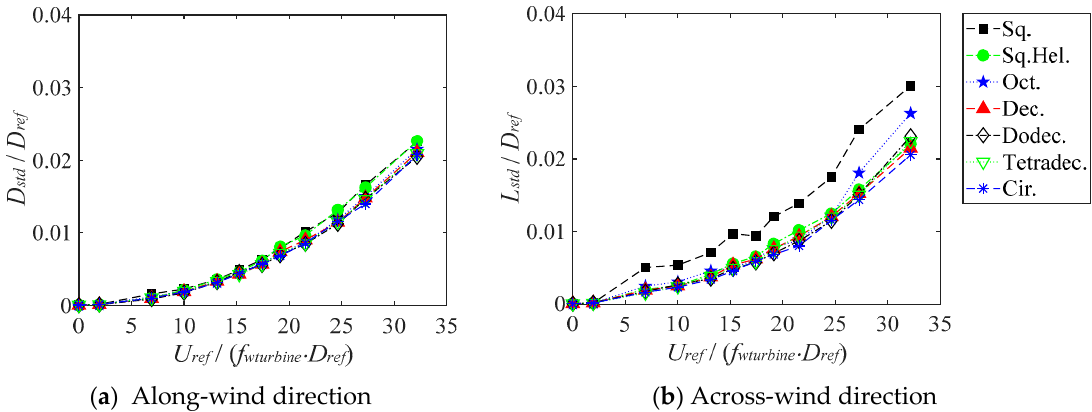
Figure 7. Maximum fluctuating displacements for wind turbines installed on seven polygonal towers [15].